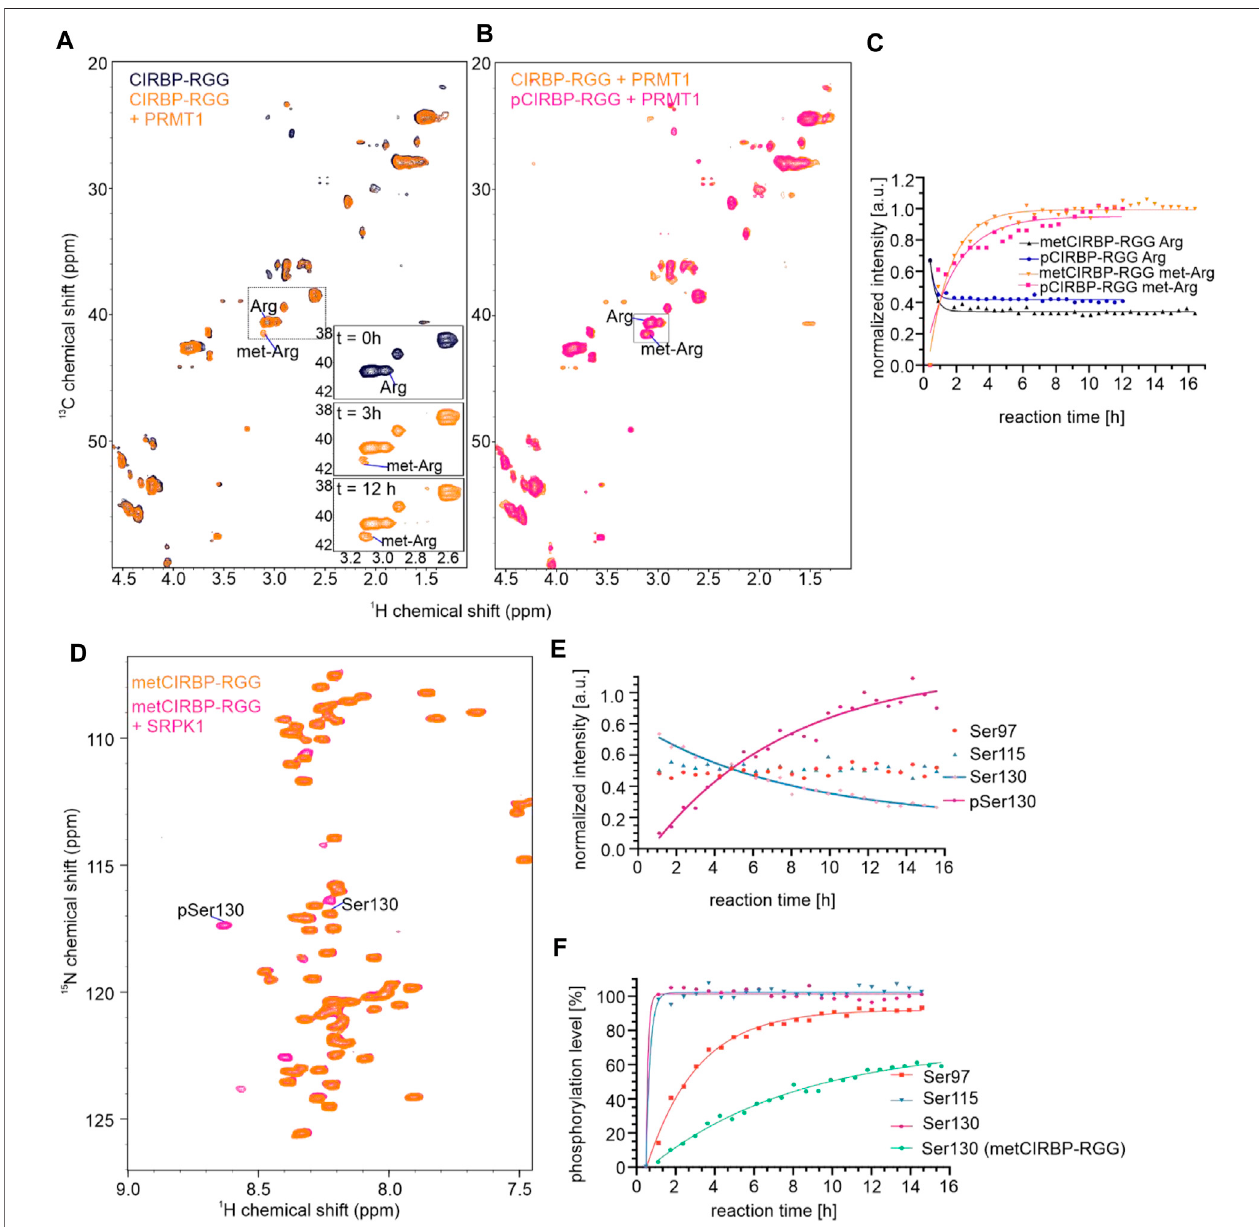
FIGURE 6 | Arginine methylation of CIRBP-RGG modulates its SRPK1-mediated phosphorylation and vice versa. (A) Overlay of 1 H- 13 C HSQC spectra of 50 µM 13 C- 15 N-labeled CIRBP-RGG in the absence (black) and presence of 10 µM PRMT1 and 2 mM SAM (orange). The region containing a peak corresponding to methylatedargininesisindicatedbyadottedbox,andtherisingintensityofmethylatedargininecrosspeakcanbefollowedatthethreeexemplarytimepointsshownina bottomrightpartofthespectrum. (B) Overlayof 1 H- 13 CHSQCspectraof 13 C- 15 N-labeled50 µMmetCIRBP-RGG(sampleasin Figure6A ;inorange)and100 µM pCIRBP-RGG in the presence of 40 µM PRMT1 and 2 mM SAM (in magenta). The region containing a peak corresponding to methylated arginines is indicated by a dotted box. (C) Change of NMR signal intensities of cross peaks corresponding to methylated and non-methylated arginines in metCIRBP-RGG (in orange and black, respectively) and pCIRBP-RGG (in magenta and dark-blue, respectively) over time (samples from Figure 6B ). (D) 1 H- 15 N HSQC spectrum of 50 µM 13 C- 15 N-labeled in vitro methylated CIRBP-RGG in the absence (orange) and presence of 25 µM SRPK1 (magenta) (E) Change of NMR signal intensity corresponding to cross peaks of SRPK1-phosphorylatedmetCIRBP-RGG serineresidues(samplefrom Figure6D ). (F) Comparisonofthecalculatedphosphorylationlevelofserines97,115and130in pCIRBP-RGG (as in Figure 1E ) with the only phosphoresidue (pSer130) in metCIRBP-RGG after the incubation with SRPK1 (sample from Figure 6D ).